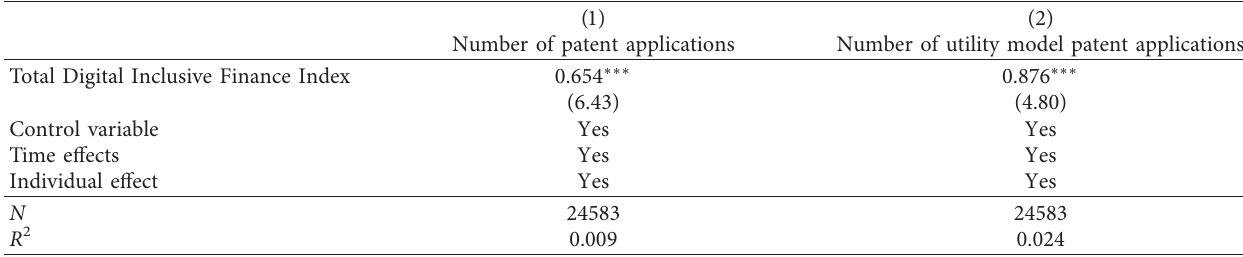
Table 2: Instrumental variable method test.